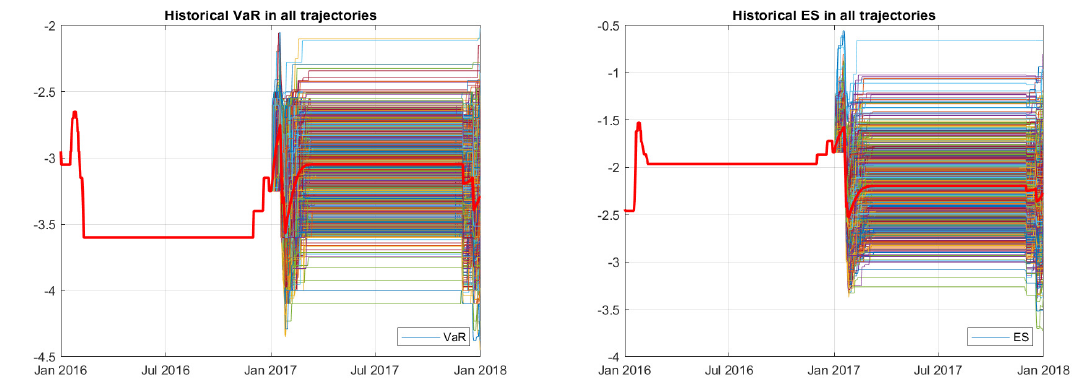
Figure 10. Simulated VaR and ES for 2017 obtained by means of 1000 trajectories using the historical